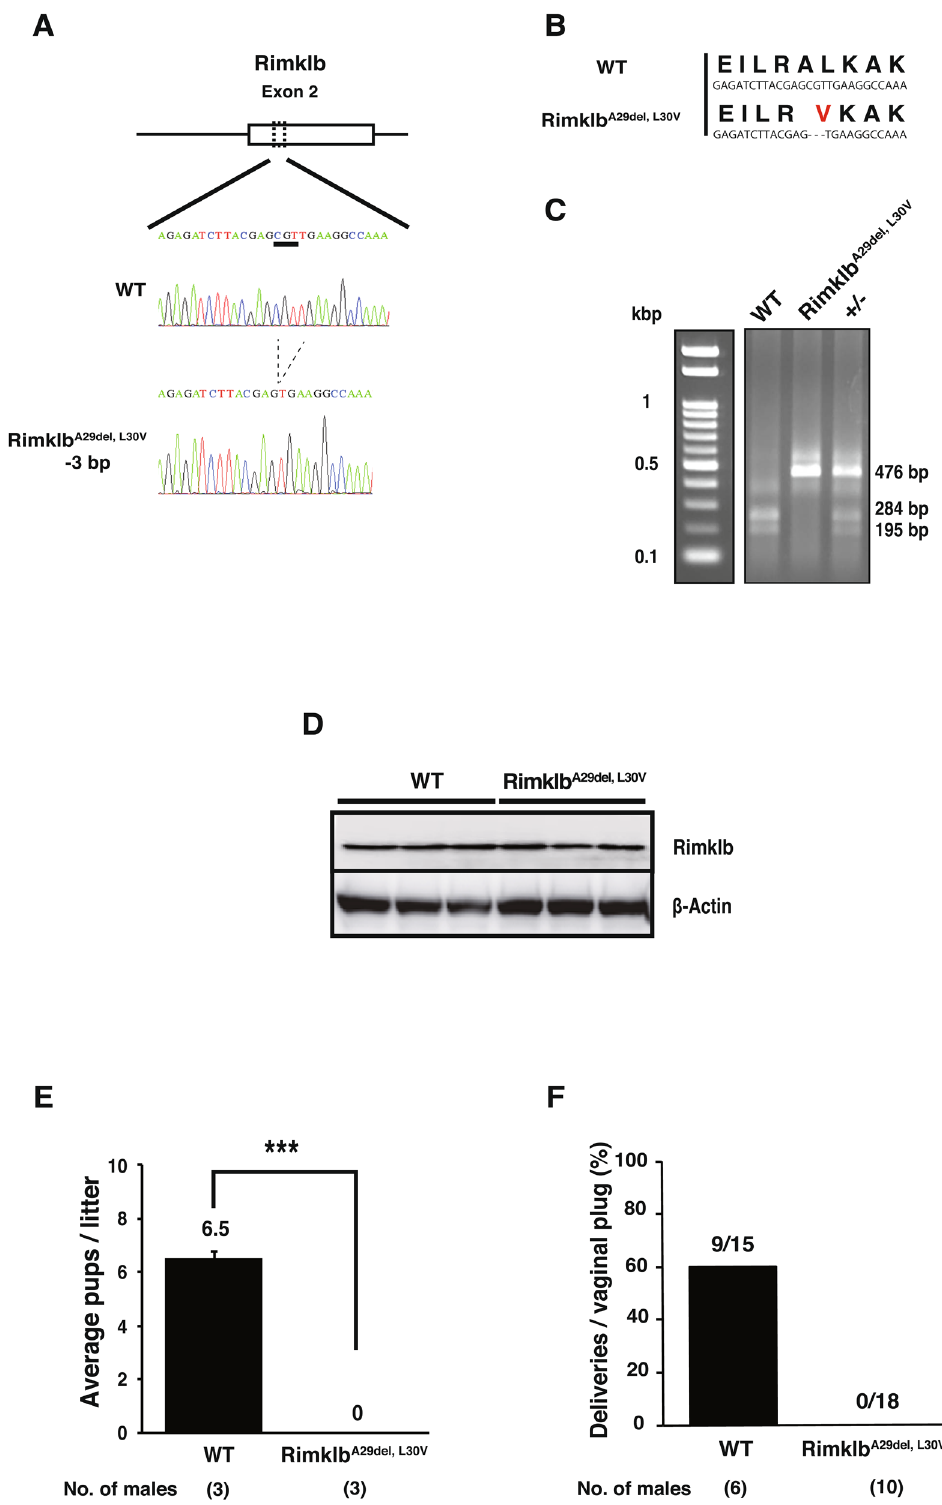
Figure 2. Rimklb A29del, L30V mutant mice are infertile. ( A ) Diagram illustrating the Rimklb A29del, L30V gene. Rimklb A29del, L30V mice had three bases deleted in exon 2 (c.351_353del). ( B ) The deletion of 3 bp altered the Rimklb ORF. The amino acid sequence corresponding to the codons (DNA sequence) is shown in smaller letters below. ( C ) Genotyping of WT, Rimklb A29del, L30V . The electrophoretic image of the PCR product after Mwo I digestion. ( D ) Western blot analysis of Rimklb in WT and Rimklb A29del, L30V mouse testis at age 12 weeks. β-Actin was used as a sample processing control. ( E ) The average number of pups per litter. Data are presented as mean ± standard error of the mean (SEM); Student’s t-test; ***p < 0.001. ( F ) Number of deliveries after vaginal plug